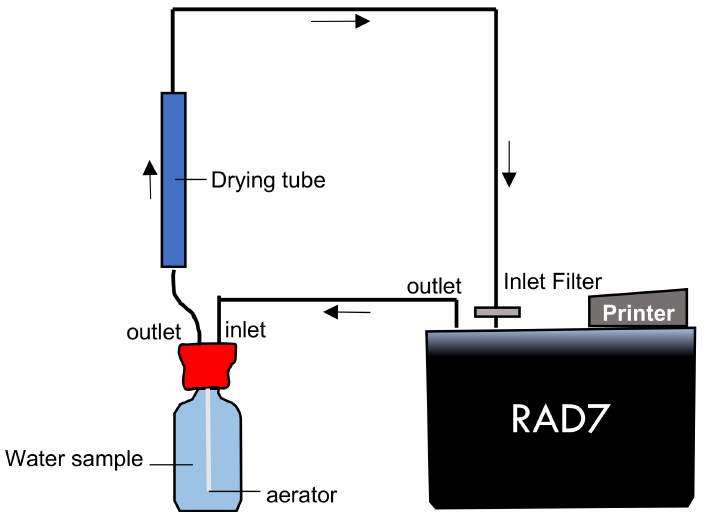
Figure 2. Schematic of experimental setup for measuring dissolved 222 Rn